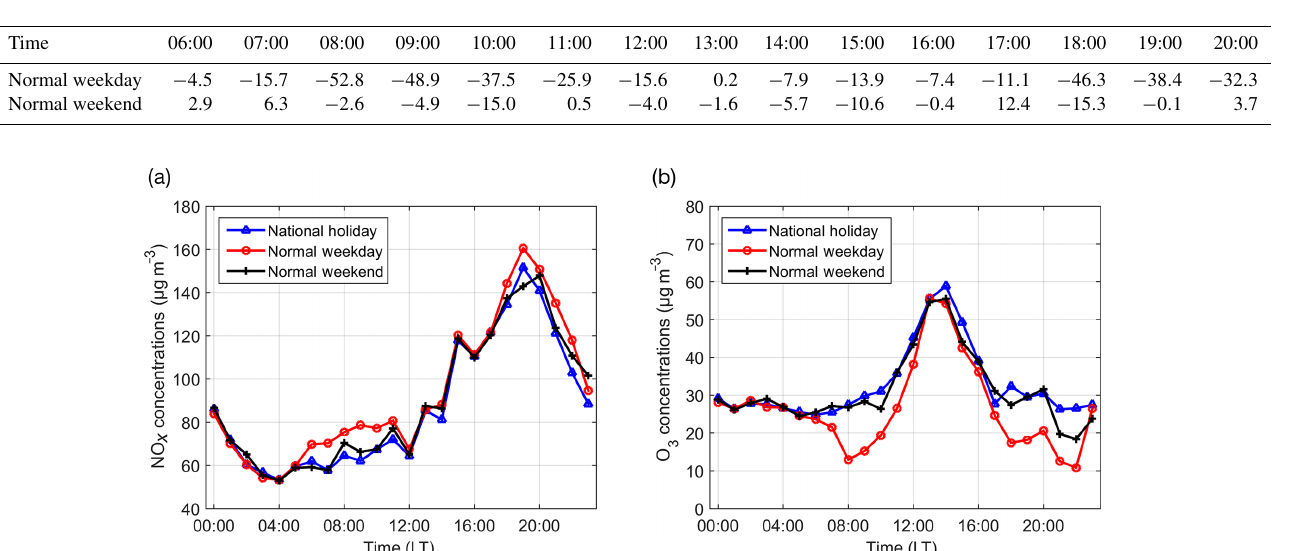
Table 6. Daytime percentage difference of O 3 compared to national holiday case.